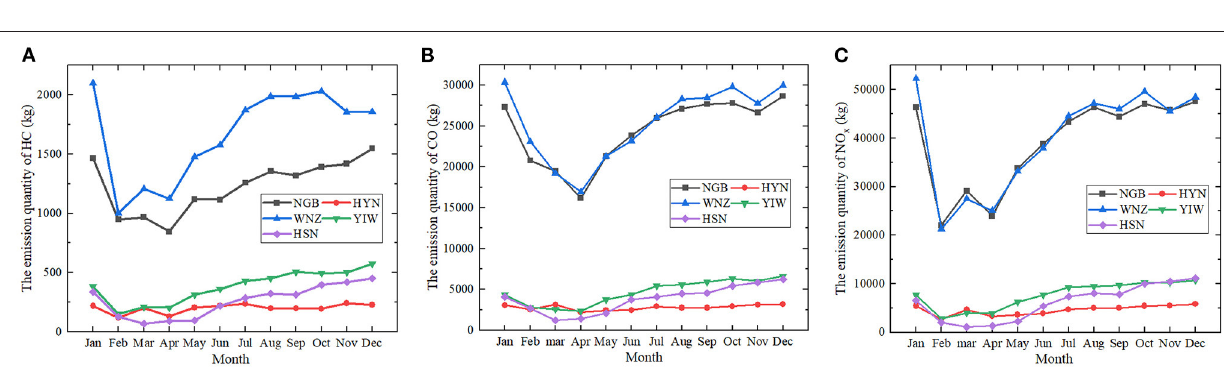
a decline of 79% for HC, 64.3% for CO, and 78.9% for NO x . These conditions surged from April to August and